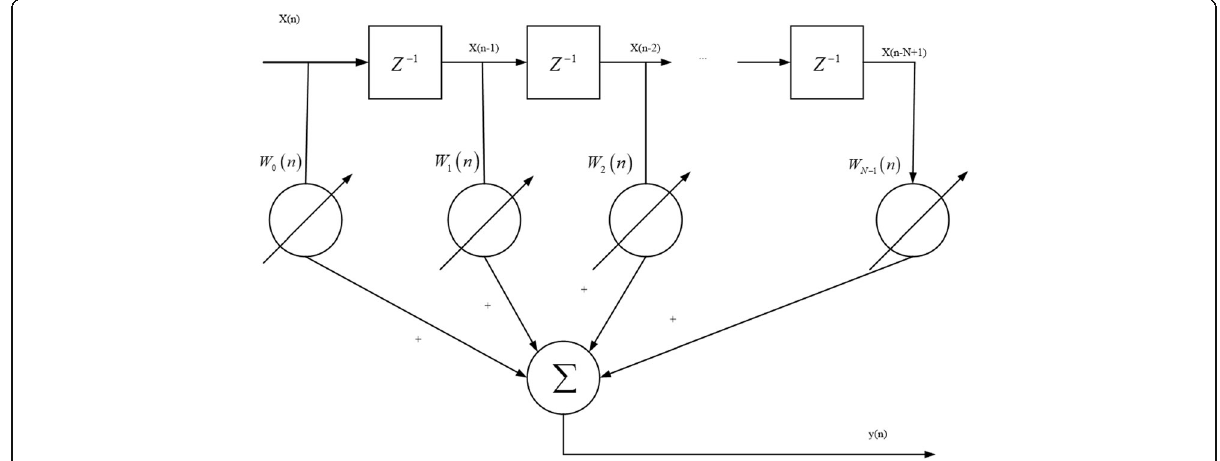
Fig. 5 The inner structure of linear transversal